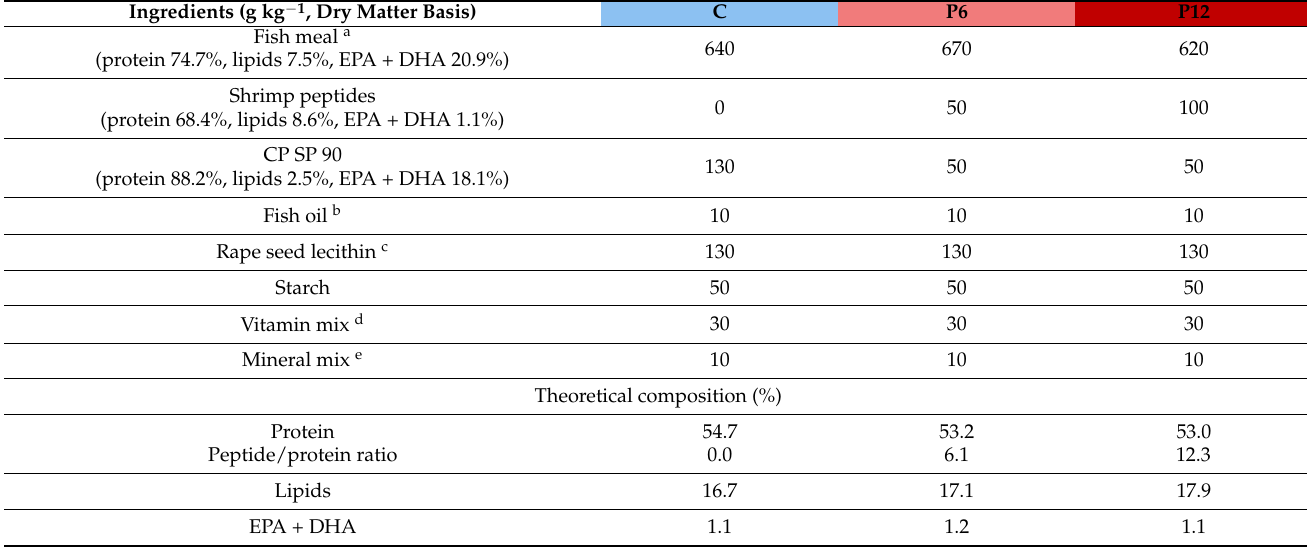
Table 1. Formulation and proximate composition of the experimental diets (C, P6, P12). Ingredients (g kg − 1 , Dry Matter Basis) C P6